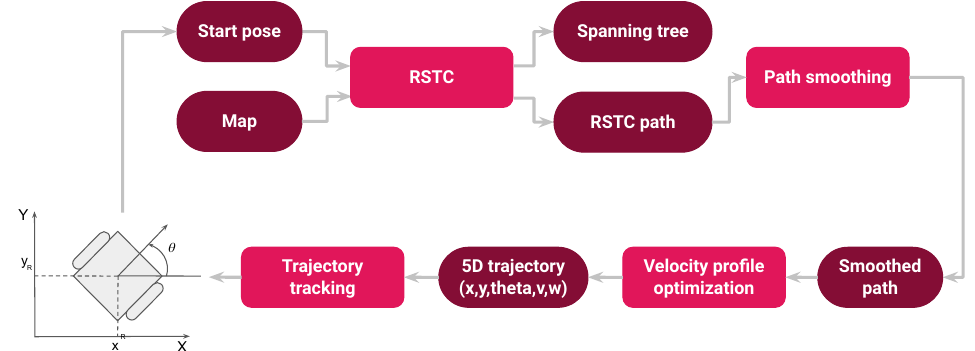
Figure 2. The pipeline of the smooth complete coverage path planning